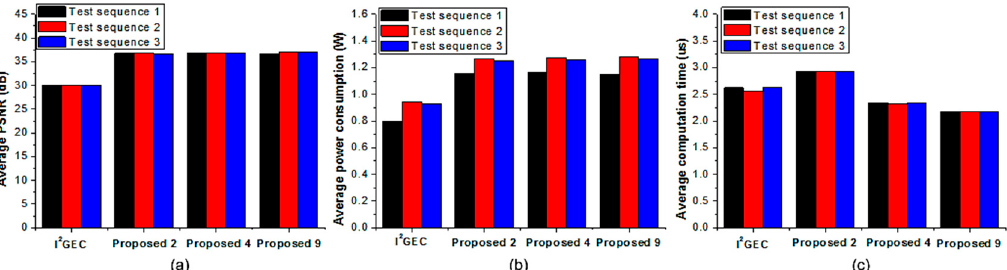
Figure 7. Graph comparisons between the proposed and benchmark algorithms: ( a ) average PSNR, ( b ) average power consumption, and ( c ) average computation time. Table 4. Comparison between the proposed and benchmark methods for the number of